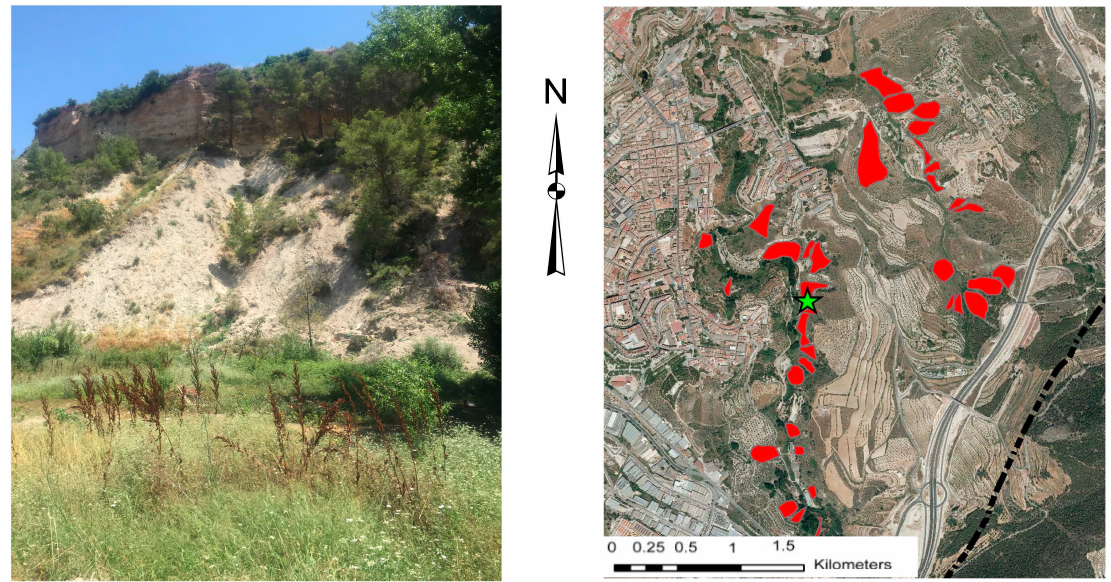
Figure 7. ( a ) Debris cover near to the Molinar River; ( b ) aerial photo of Alcoy: the red zones correspond to the Unique Condition Units (UCU) obtained for the Alcoy urban area (Instituto Cartográfico Valenciano 2017, http://www.icv.gva.es/ca/inicio)